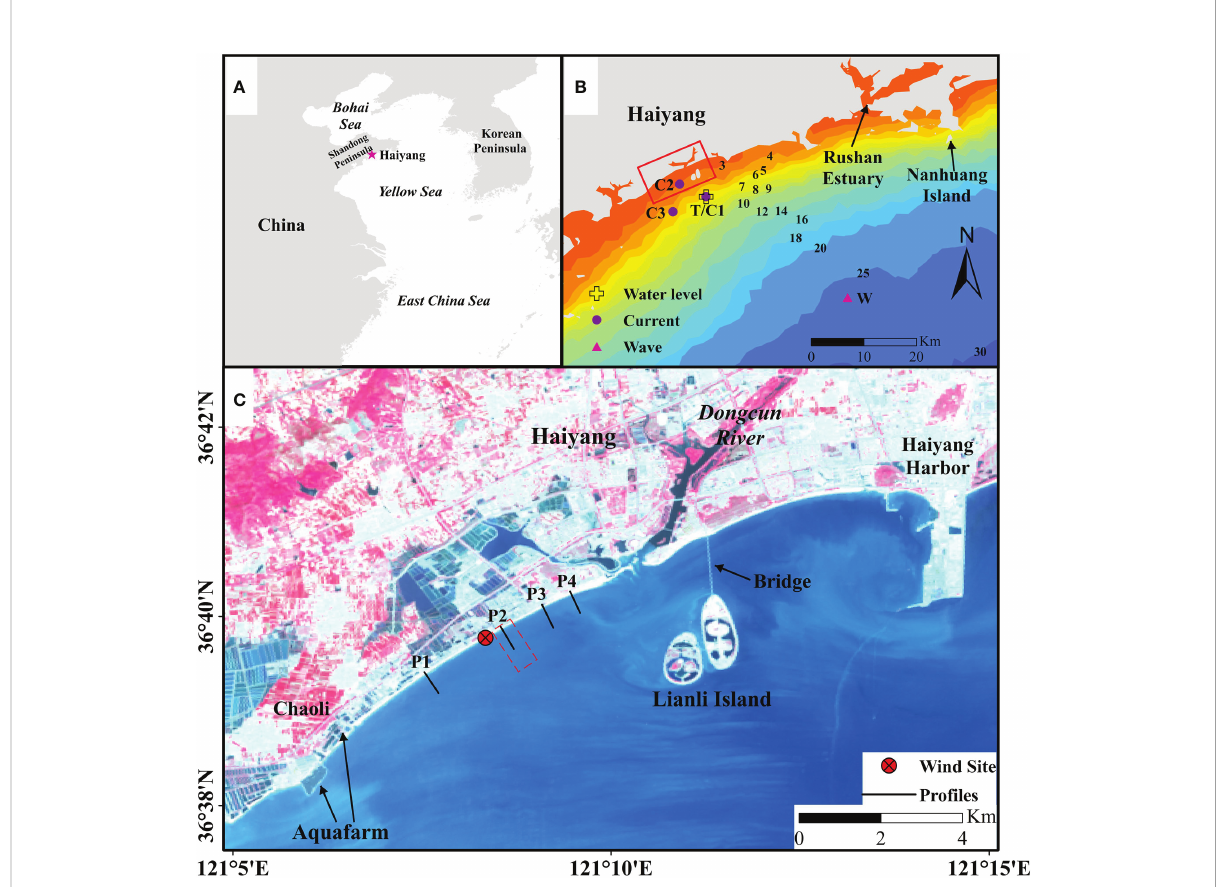
FIGURE 1 Location of the Haiyang beach indicated by the red pentacle (A) . Location of gauging station T, current observed stations C1 to C3 and wave observed station W, and the topography of the study area (B) . Layout of the observed pro fi les P1 to P4 as shown by black solid lines, and the background is a standard false-color Landsat image. The red dashed area represents the XBeach model domain, and the red dot with black cross represents the site of calculated wind conditions at Haiyang beach (C)